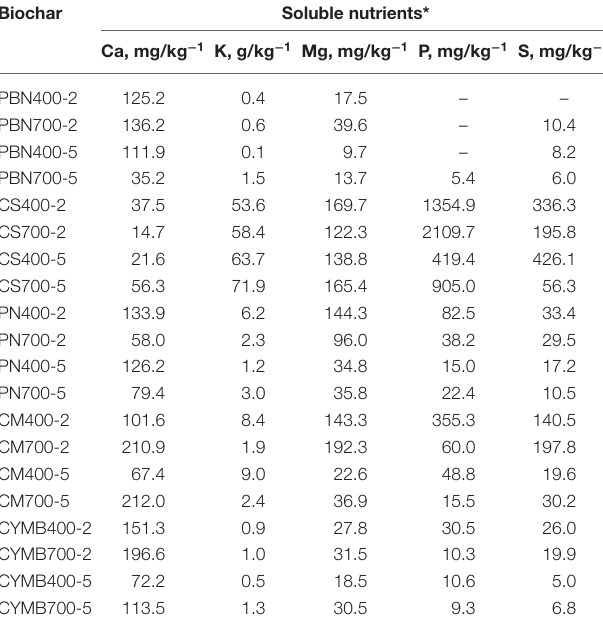
TABLE 2 | Concentrations of biochar nutrients in leachates.